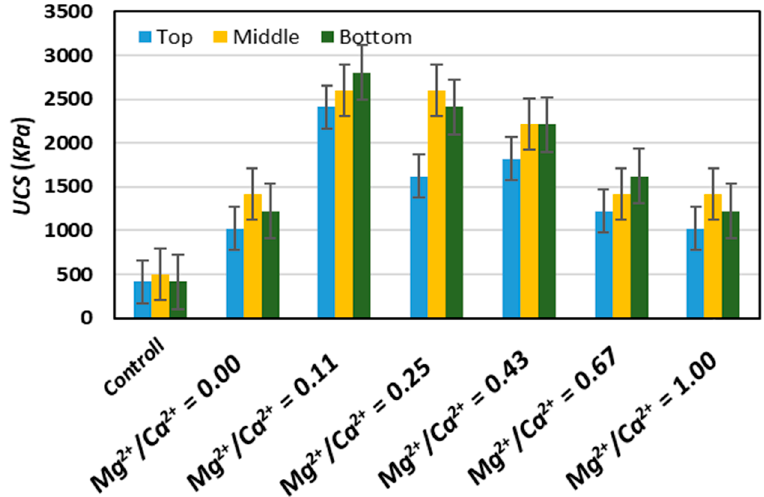
Figure 12. UCS of the solidified sand.